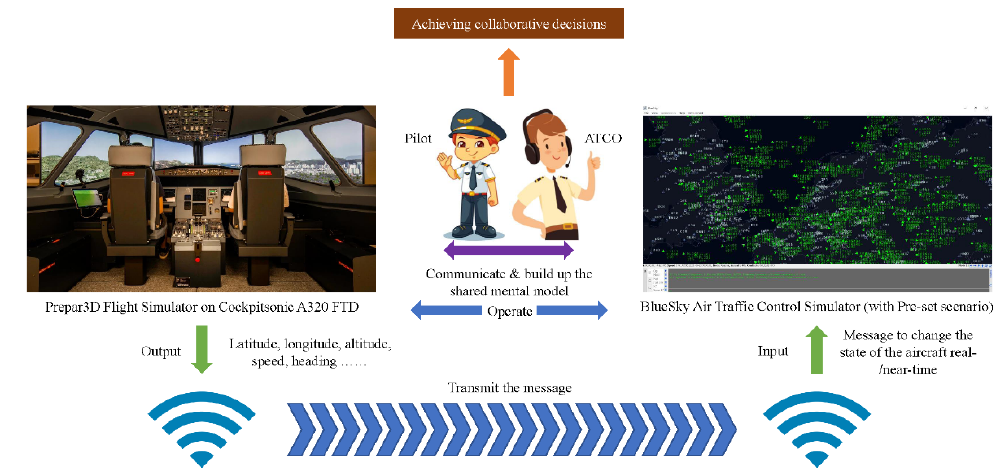
Figure 6. Conceptualised framework for training on collaborative decision making.